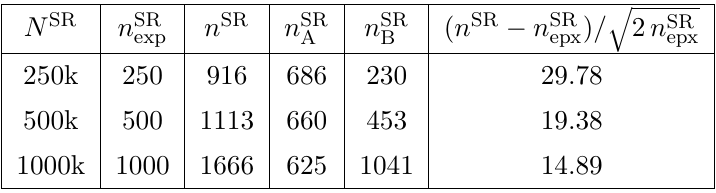
= 10 k in a signal region A